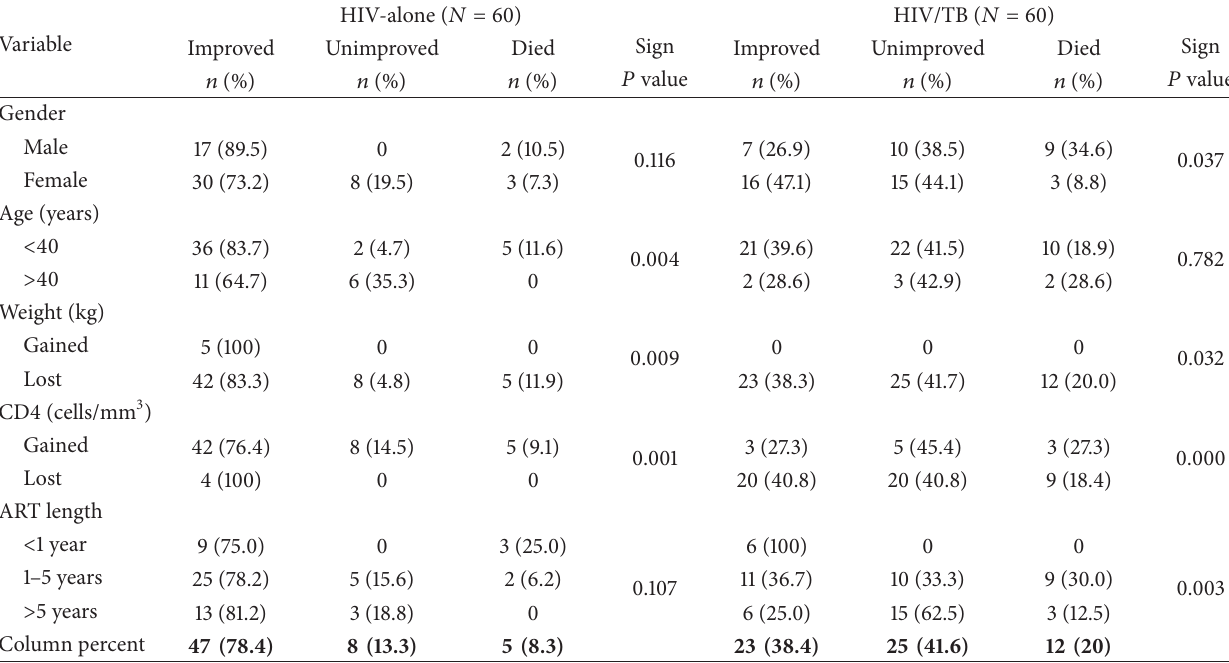
Table 3: Association between various factors and clinical